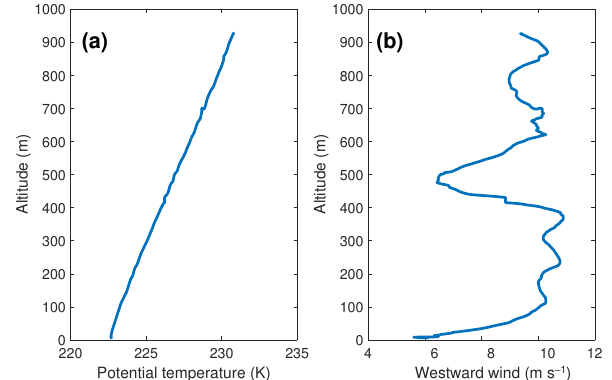
Figure 8. Potential temperature (a) and east–west component of wind speed profiles (b) from aircraft ascent on 13 March 2012 at